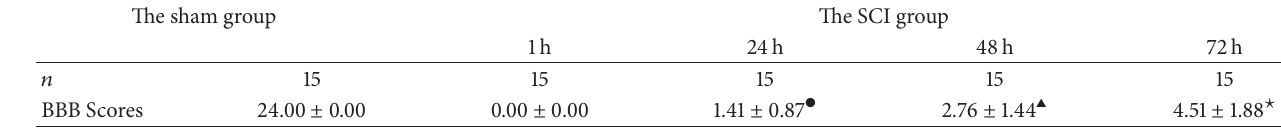
Table 2: The mean BBB scores in the rat model of